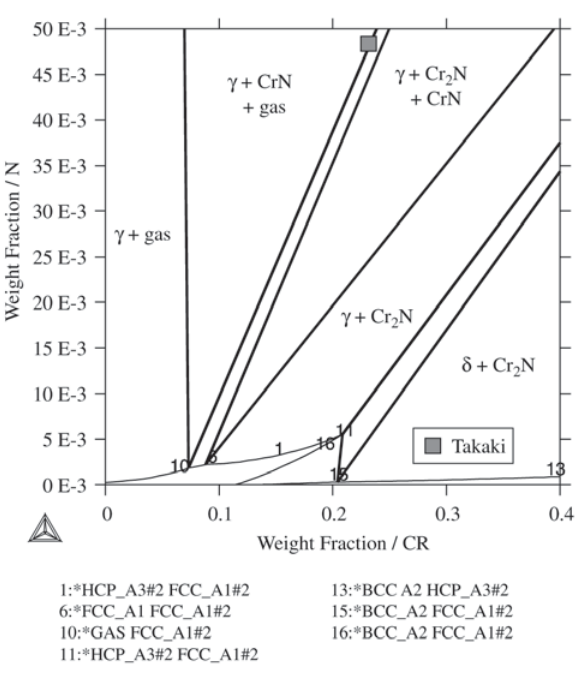
Figure 8. Isothermal section of the Fe-Cr-N phase diagram at 1,273 K and 0.1 MPa. The experimental results of Takaki are shown as small squares